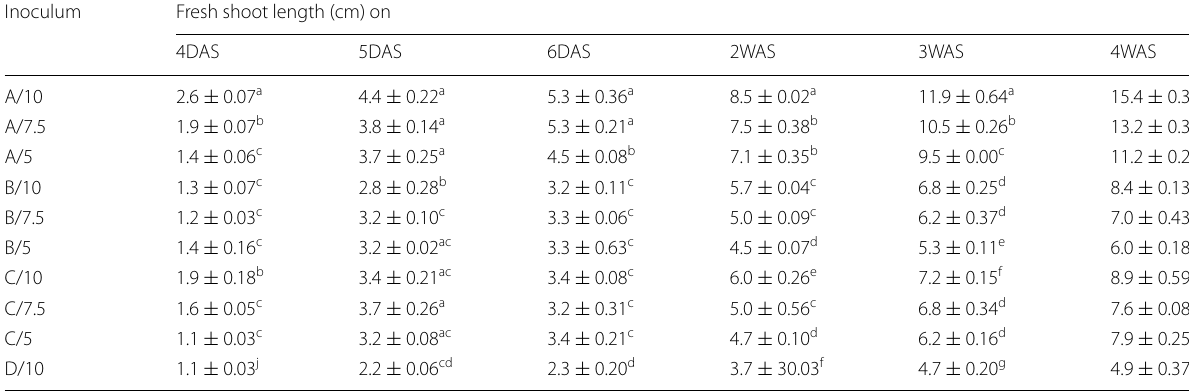
DAS Days after sowing, WAS Weeks after sowing. Results with similar alphabetic superscripts on same column did not differ from each other (p>0.05). A10, A7.5 = = and A5.0 10 ml, 7.5 ml and 5.0 ml of Bacillus sp., respectively. B10, B7.5 and B5.0 = ml and 5.0 ml of Klebsiella sp ., respectively. D10